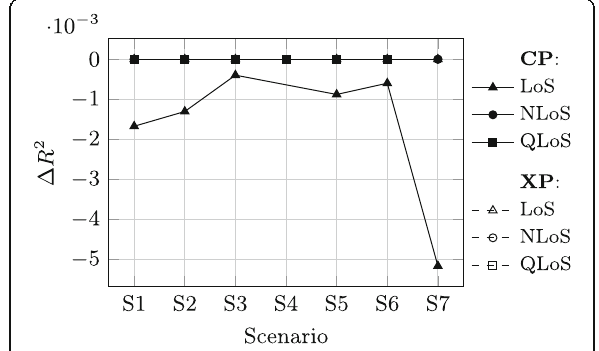
Fig. 8 Relative R 2 values compared to the approach where xLoS are considered separately and n is constrained to the value obtained for